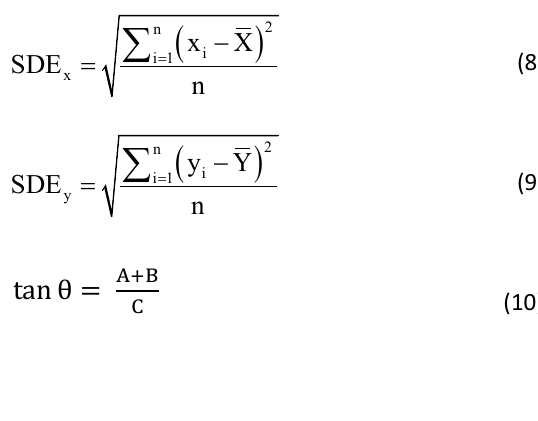
Table 6: Directional distribution results